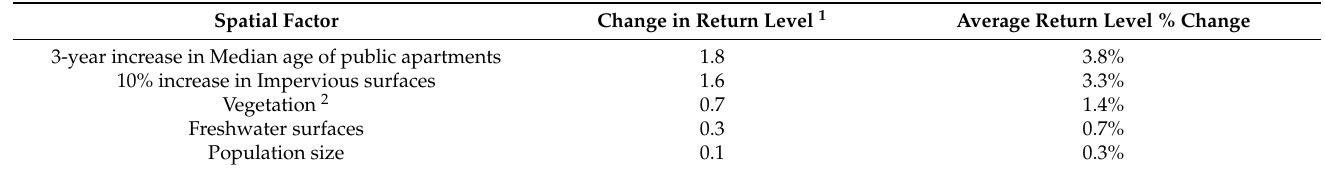
Table 4. Independent effects of per-unit change on the 30-year return levels under M1.